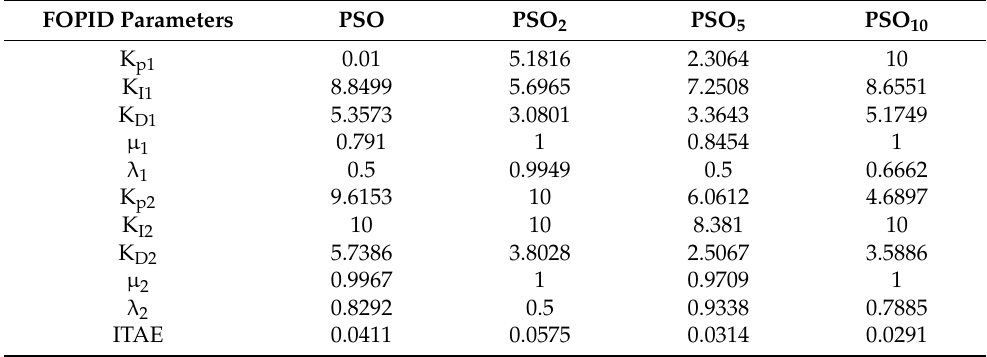
Table 3. Optimally tuned parameters of FOPID controllers with different optimisation techniques for case